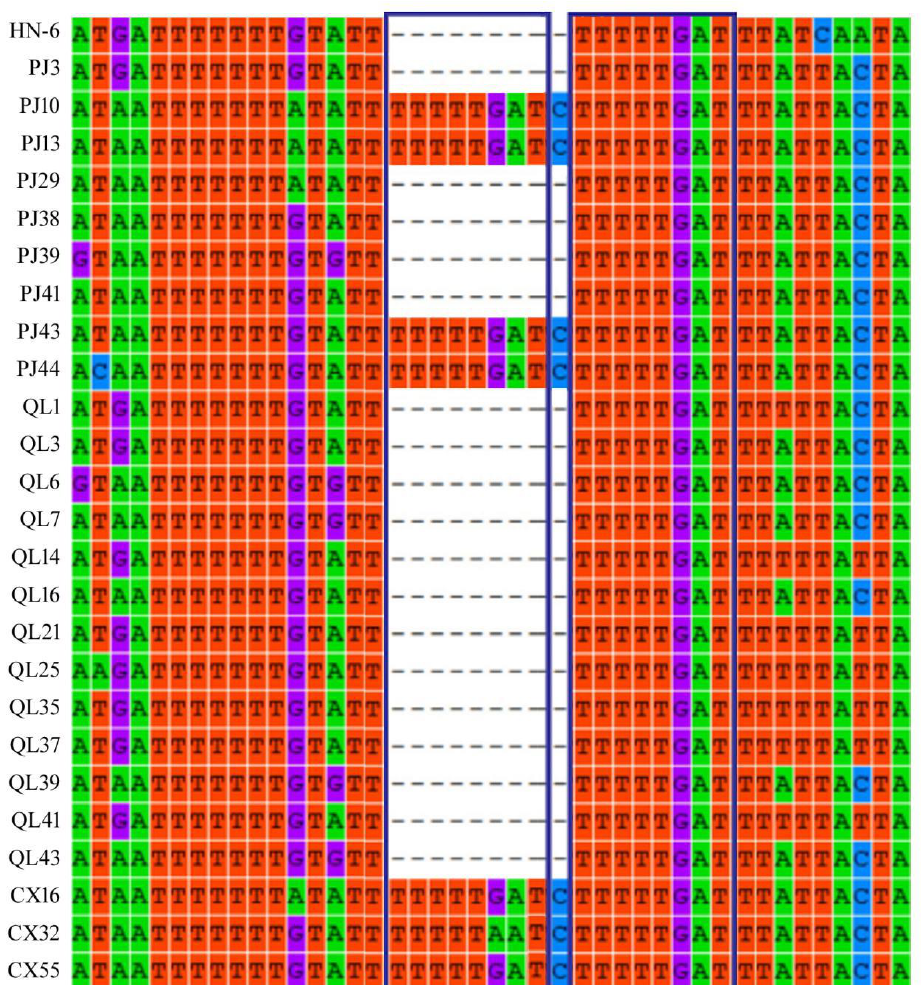
Figure 5. Multiple nucleotide sequence alignment of 26 AcCRaV isolates in the 5′ -terminal non-coding region of RNA3.